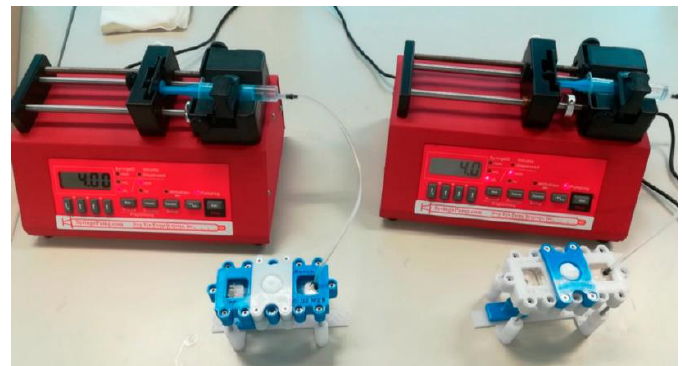
Figure 13 . The experimental setup consists of two simultaneous skins-on-a-chip [119]. This setup contains a flow-through dynamic microfluidic device and a programmable syringe pump. The experimental samples can be collected below the diffusion system in the collection bench. Reproduced with permission from MDPI Copyright (2023).